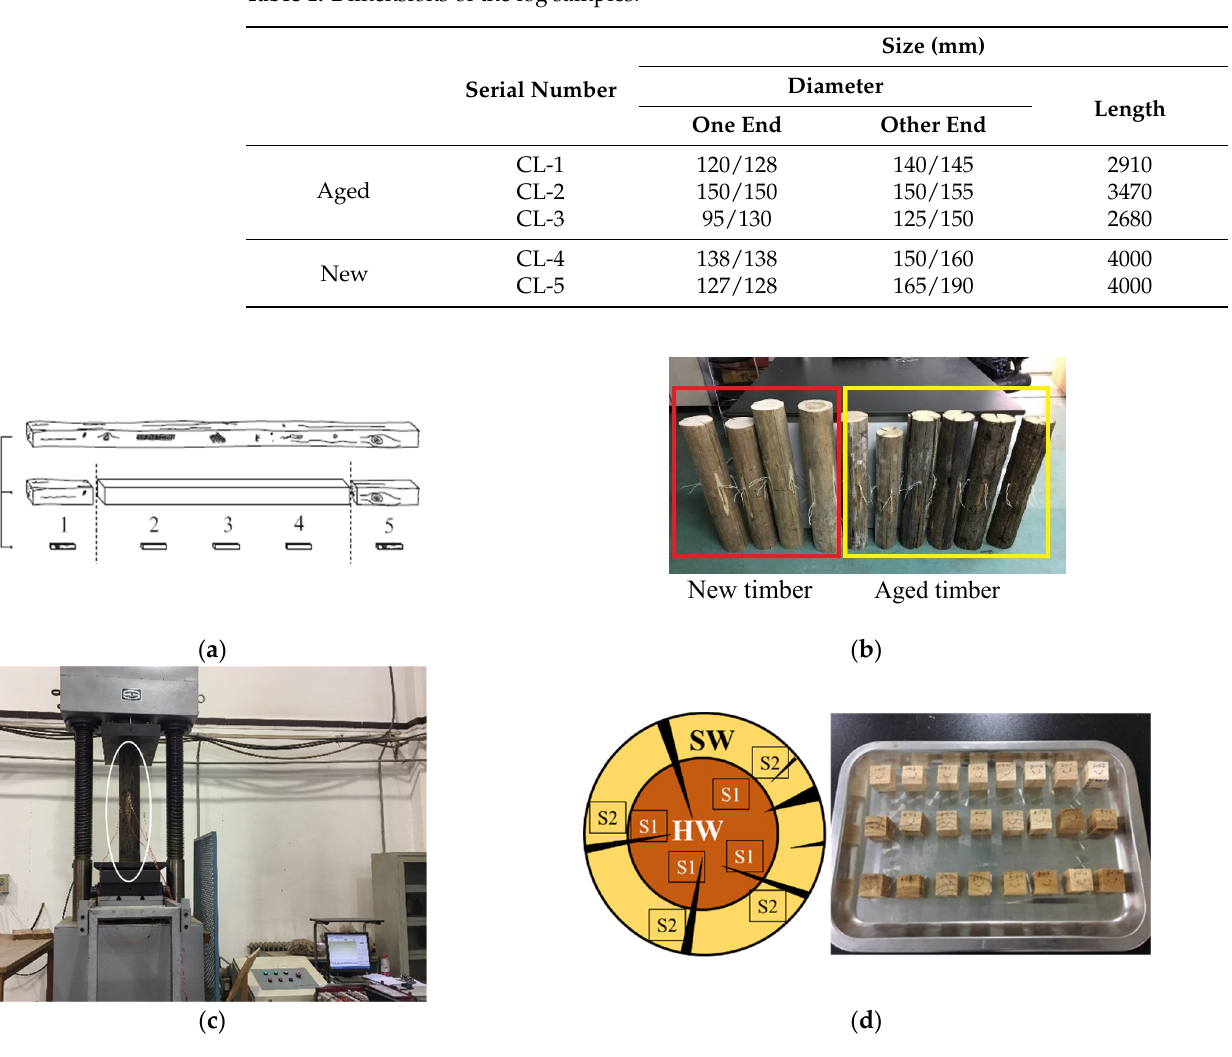
Figure 4. Segments of the timber log and the prepared test specimens: ( a ) segmenting of the timber members, ( b ) log segments, ( c ) log test, and ( d ) standard specimens. Table 2. Number of samples and their dimensions for each type of test.